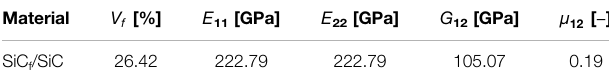
TABLE 5 | Elastic properties of SiC f /SiC woven composites (Abdi et al.,